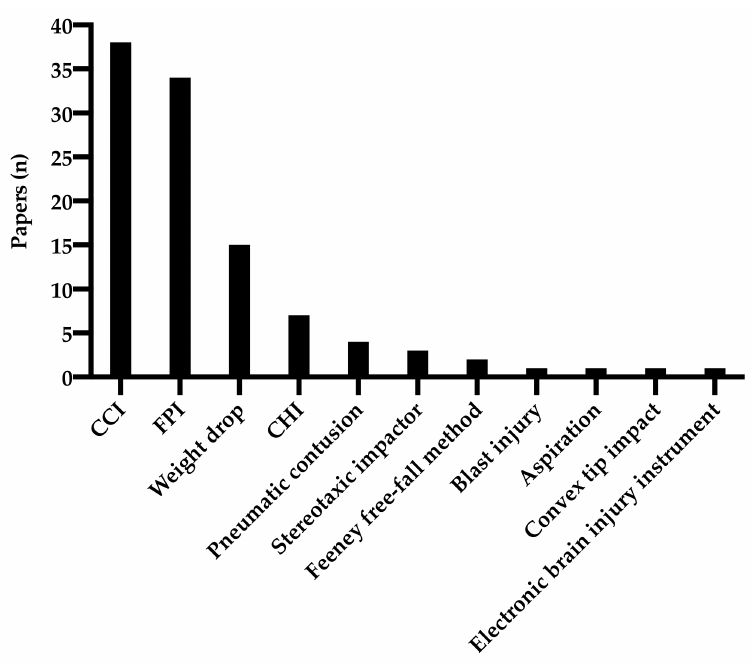
Figure 1. Trauma models in the reviewed